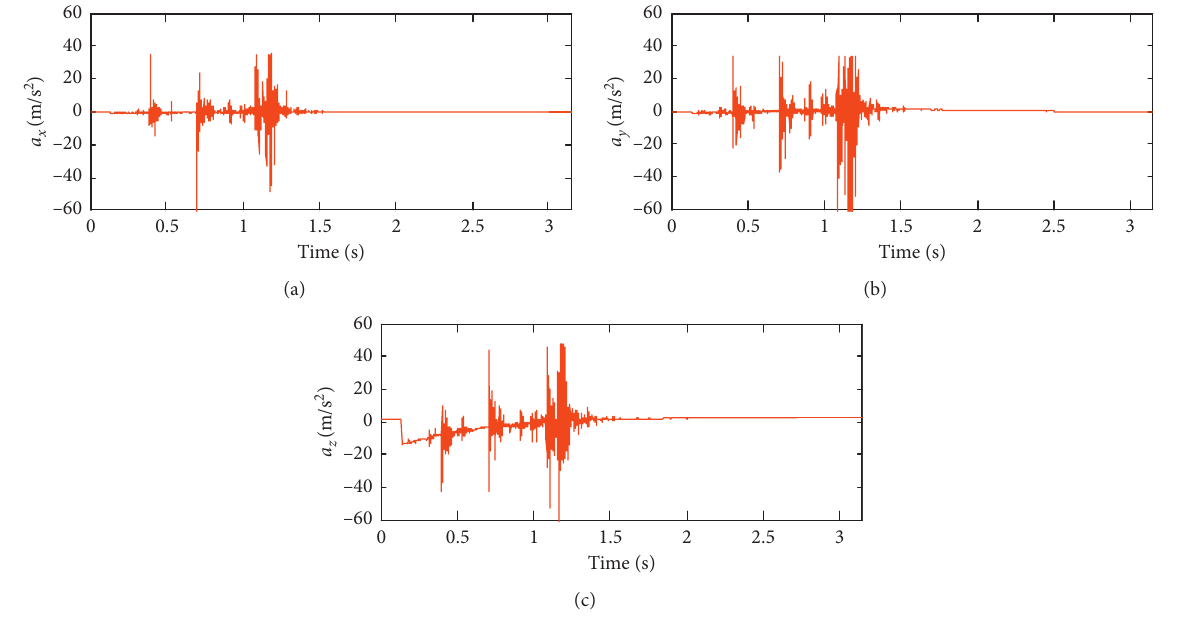
Figure 13: X axis acceleration (a), Y axis acceleration (b), and Z axis acceleration (c). Right finger in contact with material The manipulator starts to hold the material Peak